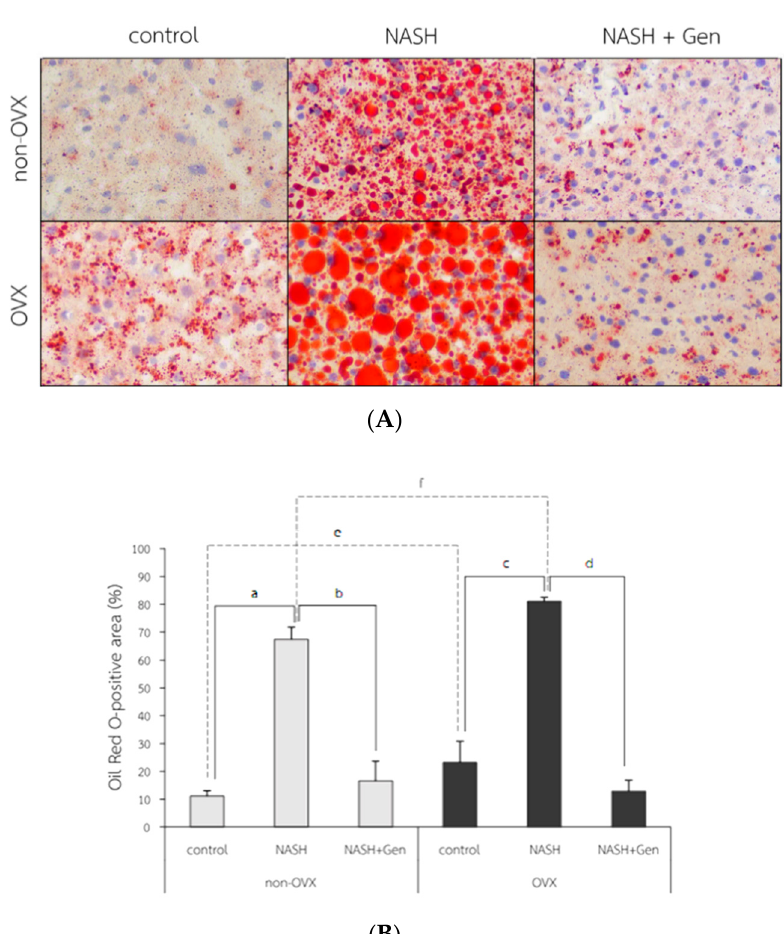
Figure 5. Fat accumulation in liver tissue. ( A ) The representative images of Oil Red O solution (ORO) staining in 6 experimental groups. Original magnification is 400x. ( B ) Percentage of ORO-positive area. a: p < 0.05 comparison between control and NASH groups of non-OVX rats. b: p < 0.05 comparison between NASH and NASH+Gen groups of non-OVX rats. c: p < 0.05 comparison between control and NASH groups of OVX rats. d: p < 0.05 comparison between NASH and NASH+Gen groups of OVX rats. e: p < 0.05 comparison between control groups of non-OVX and OVX rats. f: p < 0.05 comparison between NASH groups of non-OVX and OVX rats. Hepatic triglyceride (TG) levels significantly increased in both non-OVX and OVX rats fed with a HFHF diet as compared with control groups (non-OVX rats; 115.28 ± 43.31 vs. 37.30 ± 17.07 nmol/mg tissue, respectively; p < 0.01. OVX rats; 360.12 ± 49.06 vs. 90.75 ± 5.60 nmol/mg tissue, respectively; p < 0.01). Similar to the percentage of the ORO-positive area, hepatic TG levels were higher in OVX rats than non-OVX rats of the same diet condition (normal diet; 90.75 ± 5.60 vs. 37.30 ± 17.07 nmol/mg tissue, respectively; p < 0.01. HFHF diet; 360.12 ± 49.06 vs. 115.28 ± 43.31 nmol/mg tissue, respectively; p < 0.01). Genistein administration significantly lowered hepatic TG levels in both non-OVX and OVX rats when compared with non-treatment groups (non-OVX rats; 70.64 ± 31.29 vs. 115.28 ± 43.31 nmol/mg tissue, respectively; p < 0.01. OVX rats; 42.85 ± 15.90 vs. 360.12 ± 49.06, respectively; p < 0.01) (Figure 6A).